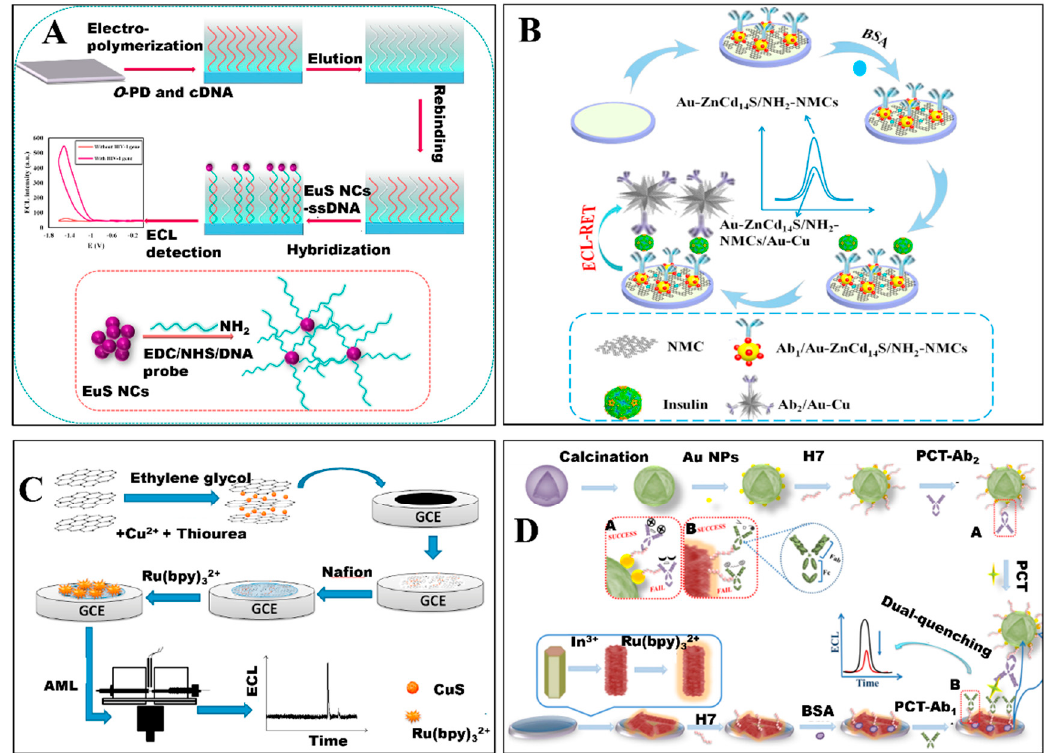
Figure 3. ( A ) Schematic diagram of the HIV gene biosensor using EuS nanocrystals as luminophore